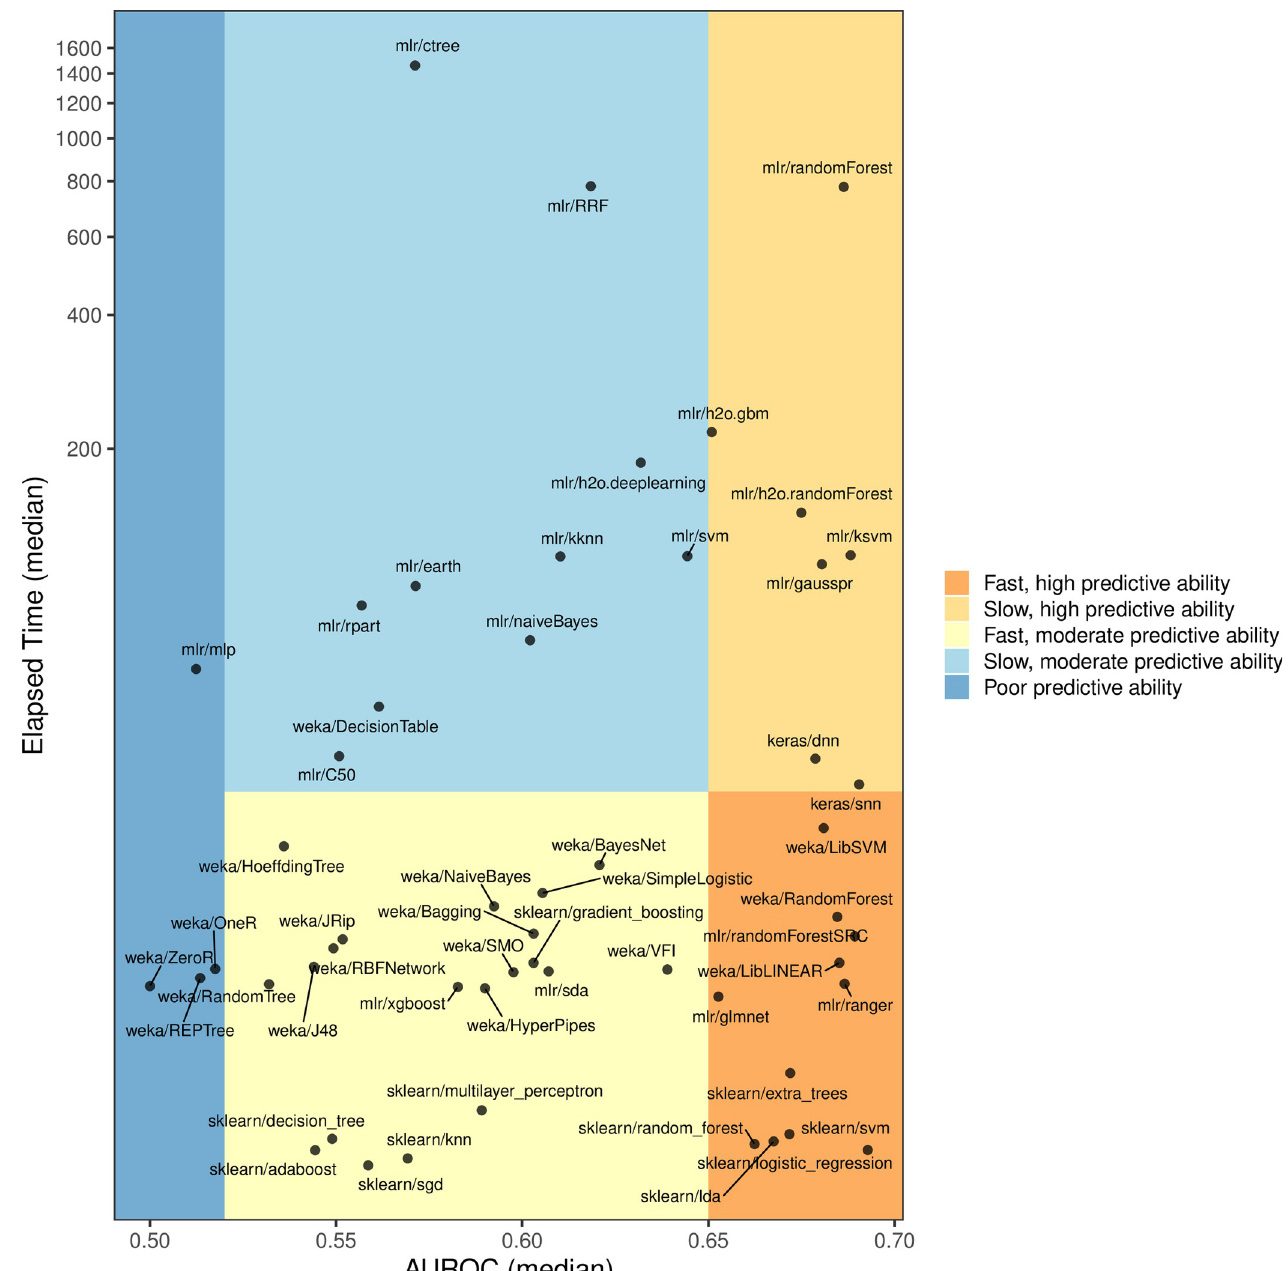
Fig 3. Tradeoff between execution time and predictive performance for classification algorithms. When using gene-expression predictors only (Analysis 1), we calculated the median area under the receiver operating characteristic curve (AUROC) across 50 iterations of Monte Carlo cross validation for each combination of dataset, class variable, and classification algorithm. Simultaneously, we measured the median execution time (in seconds) for each algorithm across these scenarios. sklearn/logistic_regression attained the top predictive performance and was the 4th fastest algorithm (median = 5.3 seconds). The coordinates for the y-axis have been transformed to a log-10 scale. We used arbitrary AUROC thresholds to categorize the algorithms based on low, moderate, and high predictive